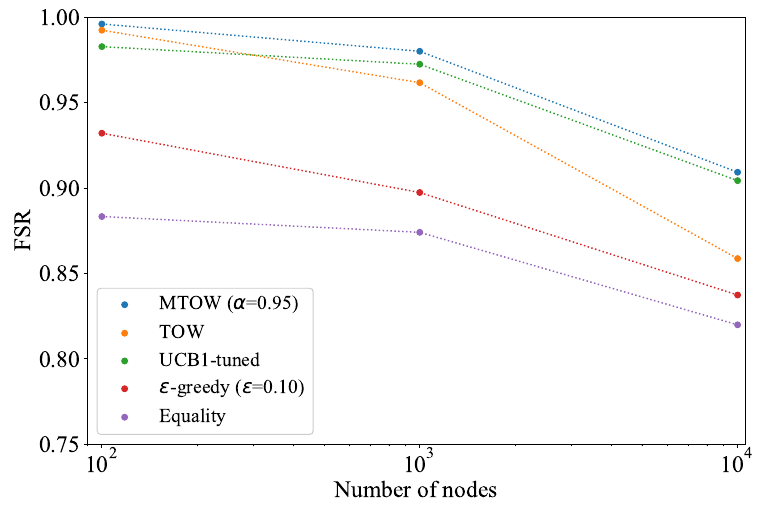
Figure 7. Number of nodes vs. FSR in the IoT network, where 30 available channels and 12 channels may be occupied by the IoT devices from the other network with λ = 0.8 and a duty ratio of